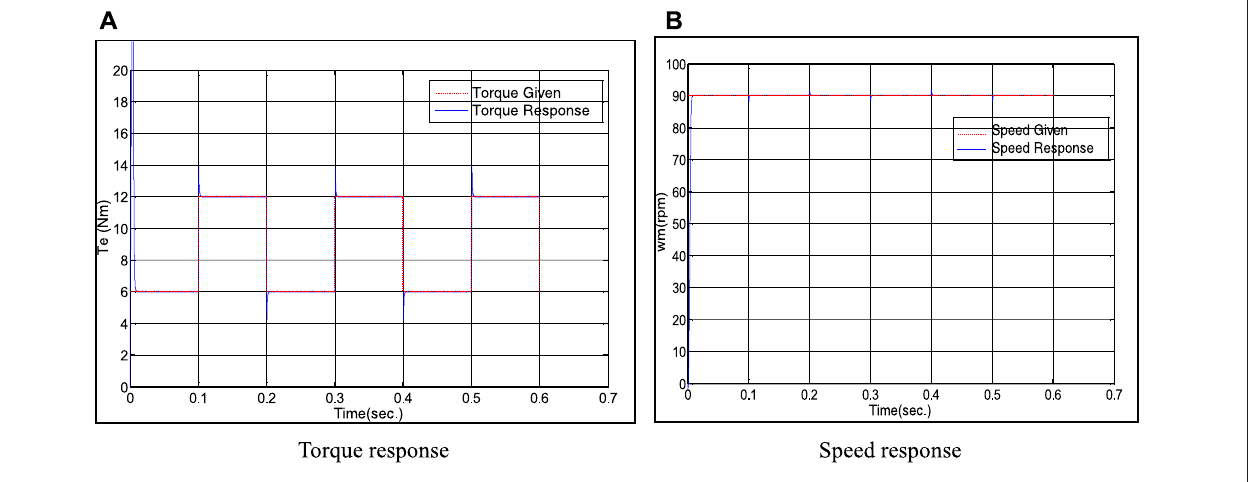
Frontiers in Energy Research |